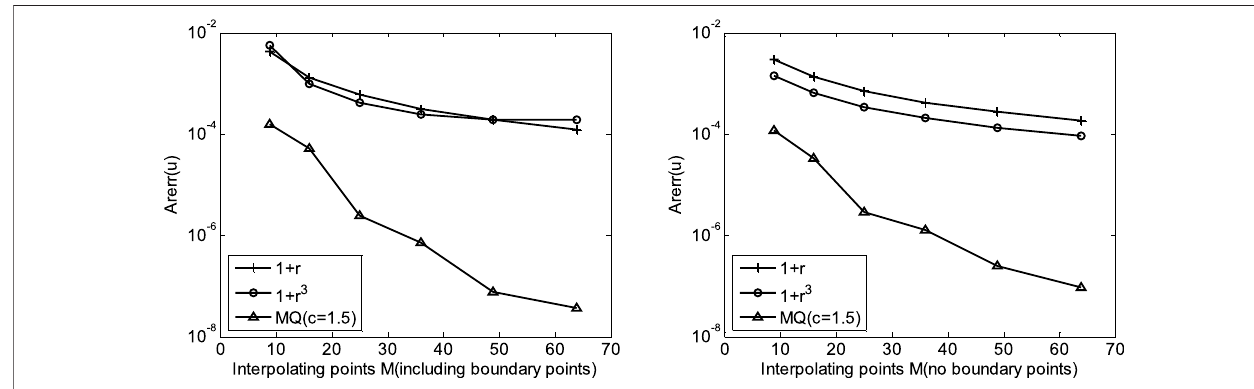
FIGURE 7 | Convergence curves of average relative error for anisotropic nonlinear convection-diffusion problems with N = 24 by using different interpolation schemes.